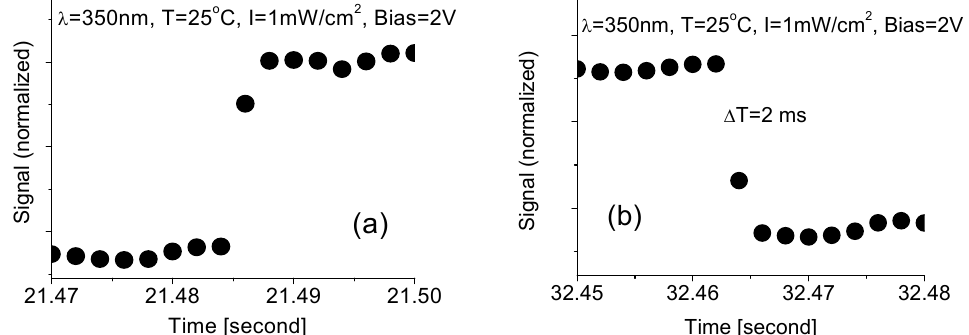
Figure 7. ( a ) Response and ( b ) recovery time of the DUV-PD exposed to 350-nm light radiation at intensity of 1 mW / cm 2 , room temperature and 2-V bias voltage.